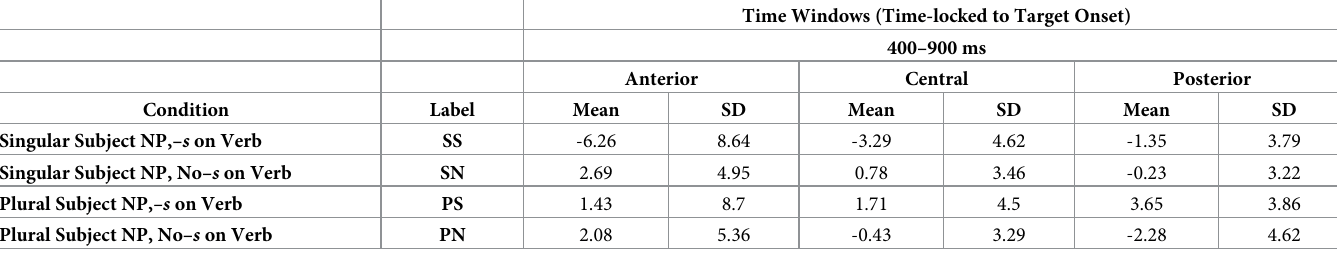
Table 6. Mean ERP amplitudes ( μ V) and their SDs for the four experimental conditions in the 400–900 ms time